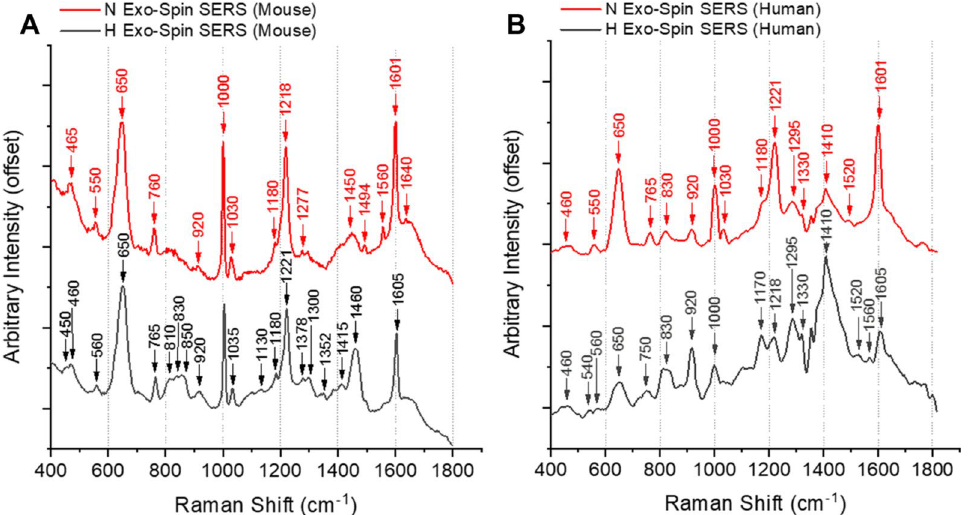
Figure 4.. Comparison of EVs released by ( A ) mouse and ( B ) human RCC cultured under normoxia (N, red) and hypoxia (H, black) with TG-SERS (all samples isolated with